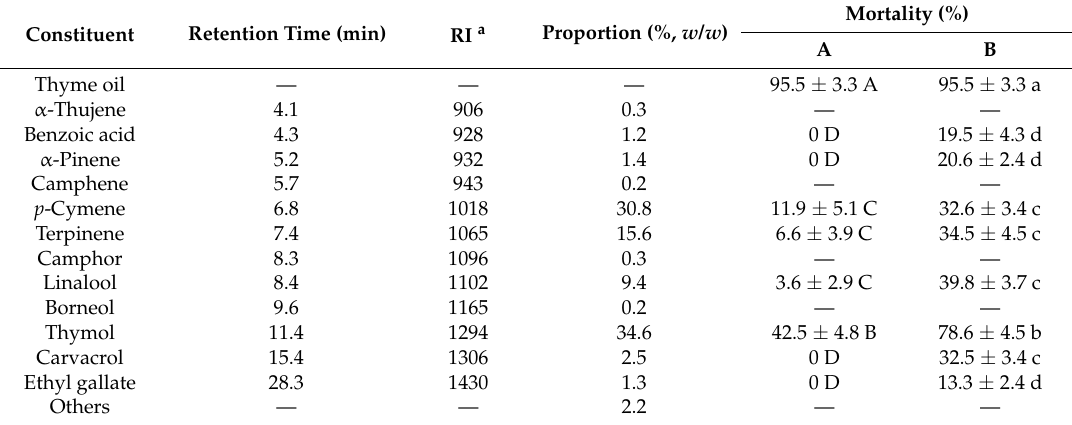
Table 1. Major constituents of thyme oil and mortality caused by thyme oil and its individual constituents.